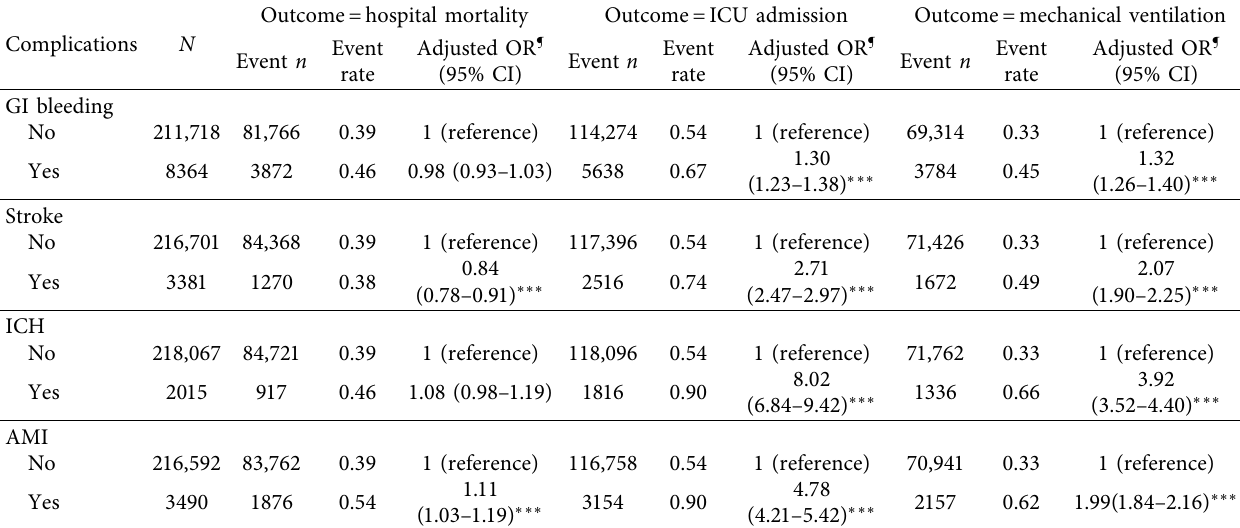
Table 2: Impact of complications on the composite hospital